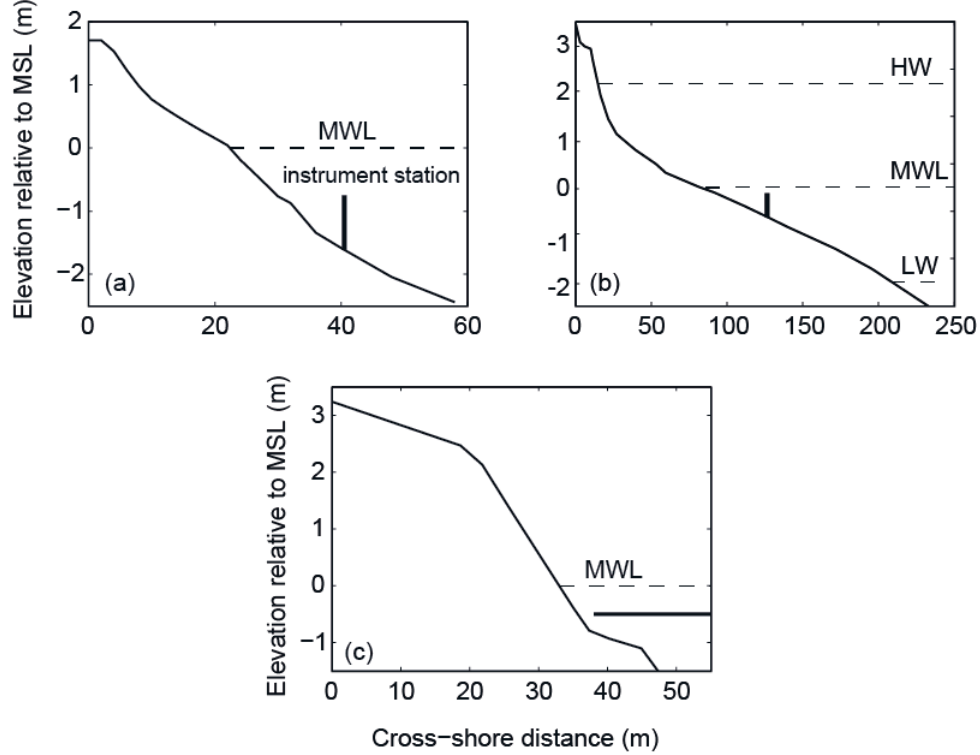
Figure 2. Cross-shore beach profiles. ( a ) Mullaloo Beach, Perth, Western Australia; ( b ) Cable Beach, Broome, Western Australia; ( c ) Ambakandawila Beach, Chilaw, Sri Lanka. In the Figure, HW, MWL and LW correspond to High Water, Mean Water Level and Low Water, respectively in terms of the tidal water